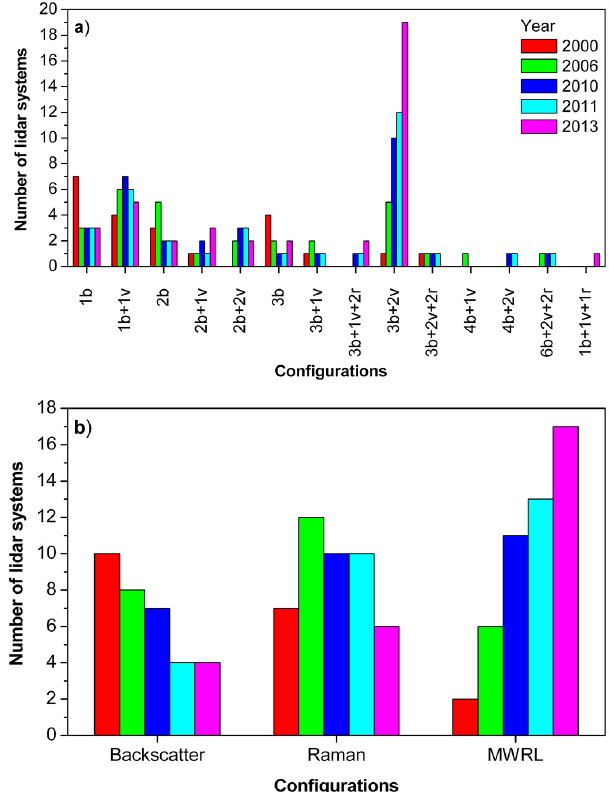
Figure 2. Development of the number of lidar systems by their con- figurations in EARLINET between 2000 (the start of EARLINET) and 2013. Configurations are classified by (a) detailing the receiv- ing system (“b” for backscatter, “v” for vibrational Raman, and “r” for rotational Raman, where the number before each letter indicates the number of wavelengths for which the “b”, “v”, and “r” are mea- sured) and (b) grouping the receiving systems in larger configura- tion classes: backscatter lidars, Raman lidars, multiwavelength Ra- man lidars